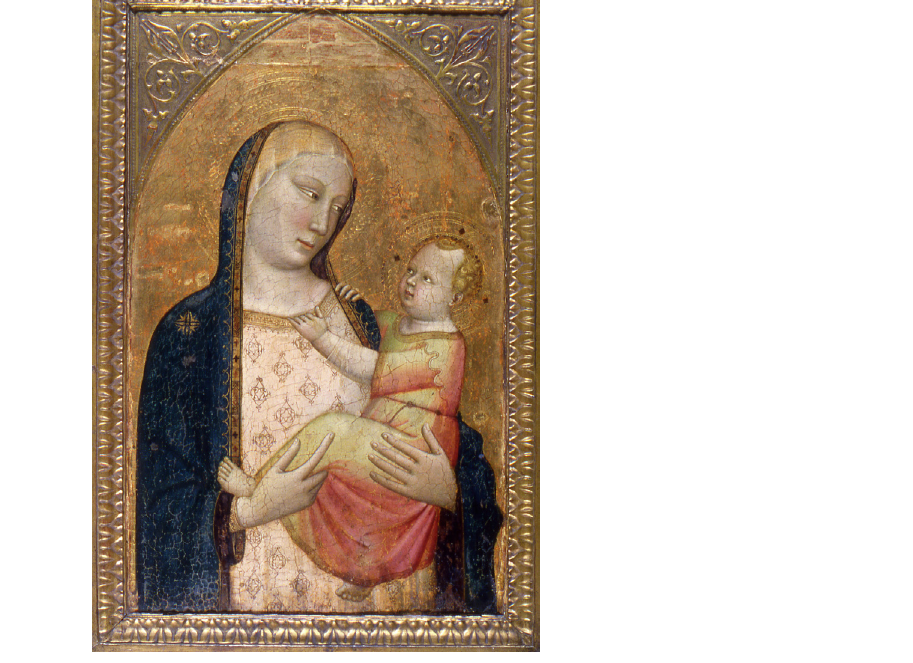
Figure 11. Workshop of Bernardo Daddi. Madonna and Child . 1345–1349. Tempera and gold leaf on panel, 27 1/16 x 18